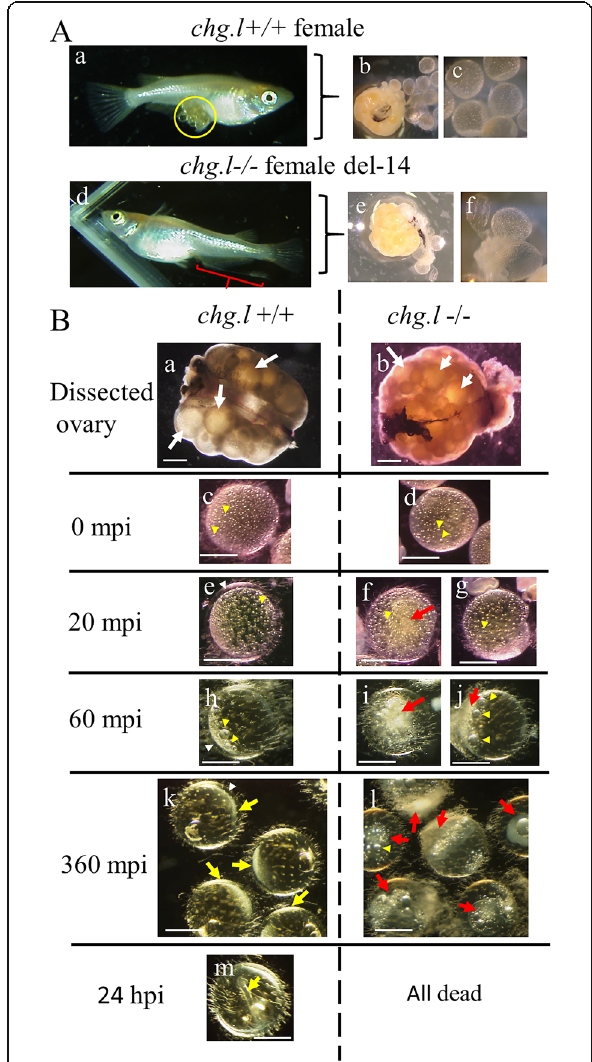
Fig. 3 Spawning females, ovaries, and oocytes of chg.l+/+ and chg.l − / − medaka. Panel A Spawning females, dissected ovaries, and ovulated eggs of chg.l+/+ and chg.l − / − medaka. Aa and Ab chg.l+/+ and chg.l − / − females, respectively, with a yellow circle highlighting spawned eggs in from the former and a red bracket highlighting spawned string-like materials containing “ smashed eggs ” from the latter. Ac and Ad Isolated ovary and ovulated eggs from the chg.l+/+ female. Ae and Af Isolated ovary and ovulated eggs from the chg.l − / − female. Panel B Changes in the artificially inseminated eggs. Ba and Bb chg.l +/+ and chg.l − / − ovaries, respectively, used to obtain ovulated and fully-grown oocytes (white arrows) for this “ in vitro fertilization ” experiment. Bc and Bd chg.l+/ + and chg.l − / − eggs, respectively, immediately before insemination. Be and Bf-g chg.l +/+ and chg.l − / − eggs, respectively, at 20min post- insemination (mpi). Bh and Bi-j chg.l+/+ and chg.l − / − eggs, respectively, at 60 mpi, Bk and Bl chg.l+/+ and chg.l − / − eggs, respectively, at 360 mpi, Bm chg.l+/+ eggs at 120h post-insemination (hpi). White arrowheads show the perivitelline space in Be , Bh , and Bk . Yellow arrowheads show oil droplets in Bc-h and Bj . Yellow arrows show developing embryos in Bk and Bm . Red arrows show white turbidity, such as emulsions in Bf , Bi , and Bl . Scale bars in Aa and Ab =1cm; in Ac-f and Ba-b =1mm; and in Bc-l